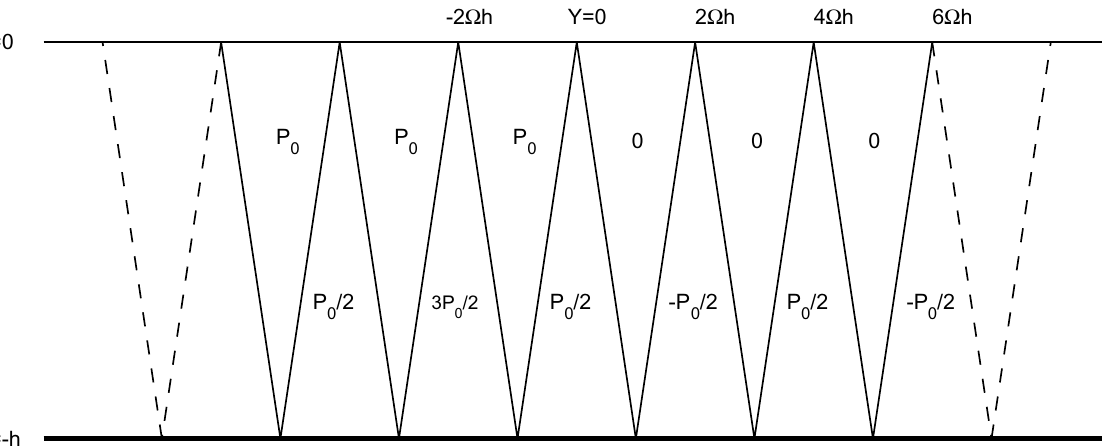
Fig. 7. Distribution of pressure accounting for anti-symmetrical and constant